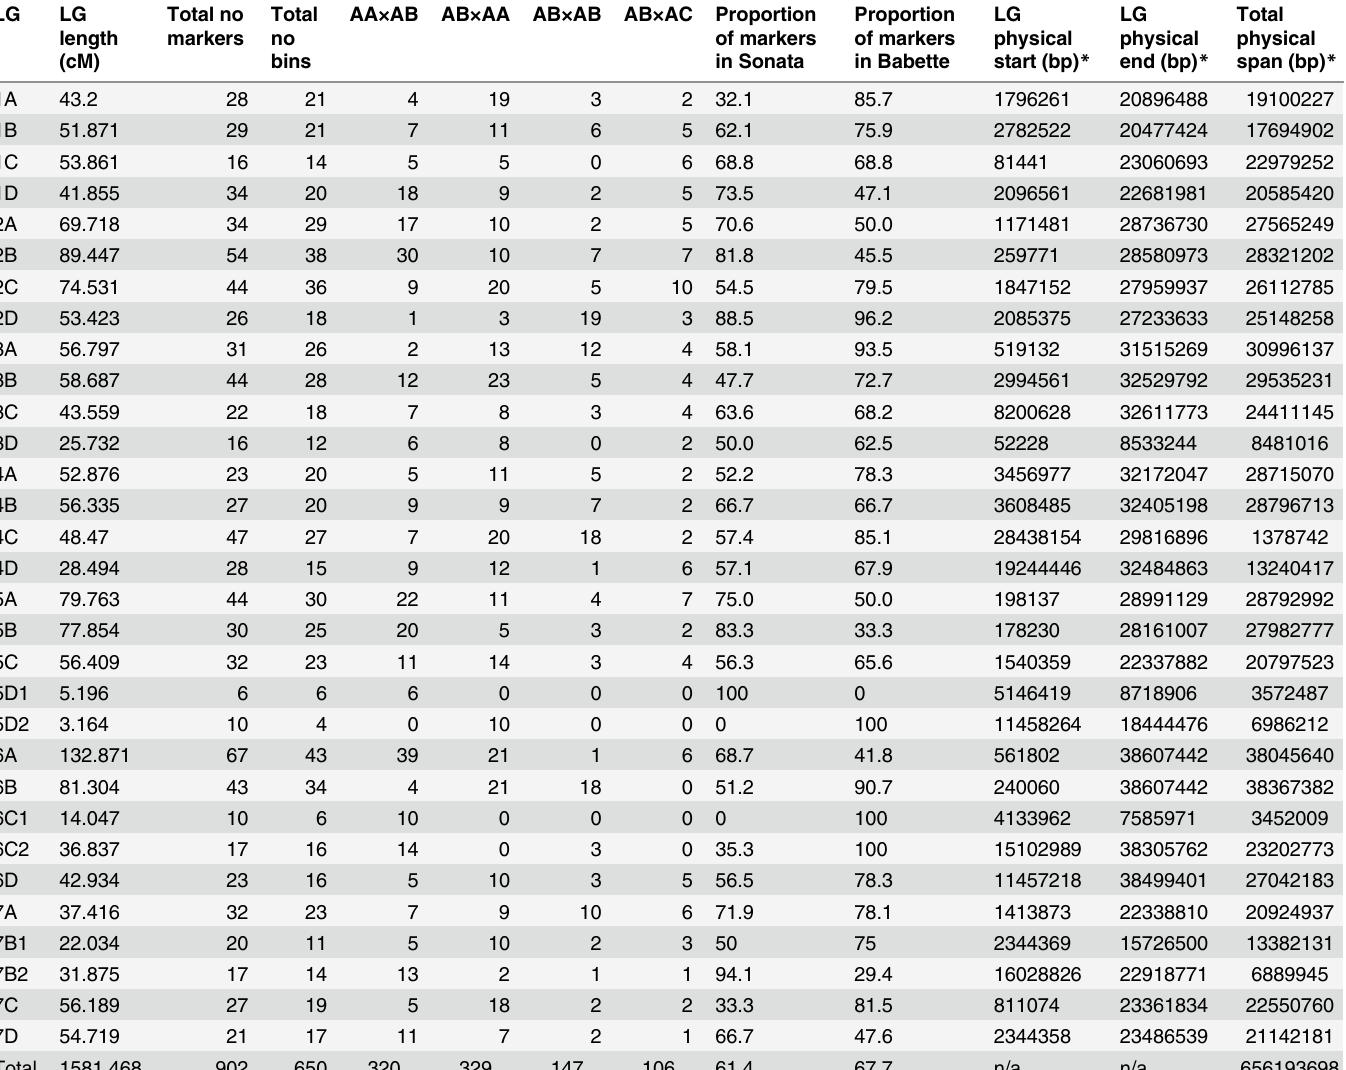
Table 1. Summary statistics for the 31 linkage group fragments that comprise the S×B linkage map, including the total number of markers mapped per linkage group, the numbers and proportions of the different segregation classes, the proportion of markers heterozygous in each parental genome, linkage group lengths and the physical distances associated with each group on the v2.0 F. vesca genome sequence.